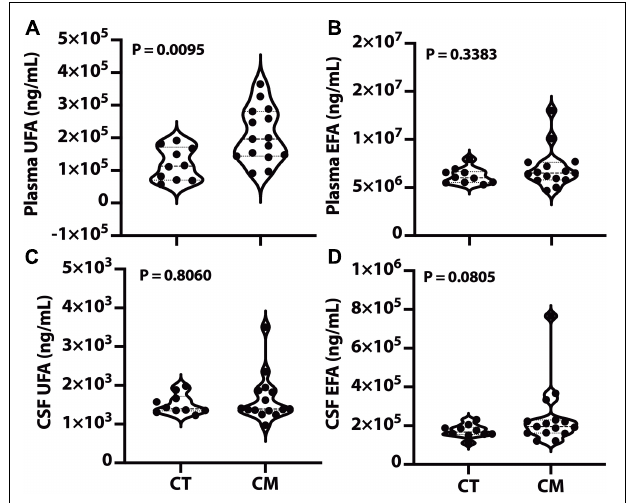
FIGURE 1 | Plasma and CSF unesterified (UFA) and esterified fatty acids (EFA). Lipids were extracted from plasma/CSF, and the levels of the sum of all unesterified or esterified fatty acids > C14:0 were quantified for CT and CM. The violin plots show plasma UFA (A) , plasma EFA (B) , CSF UFA (C) , and CSF EFA (D) . In the violin plots, the lower dotted line is the first quartile, the middle line is the median, and the top dotted line is the third quartile. The p values were determined using a Mann–Whitney U